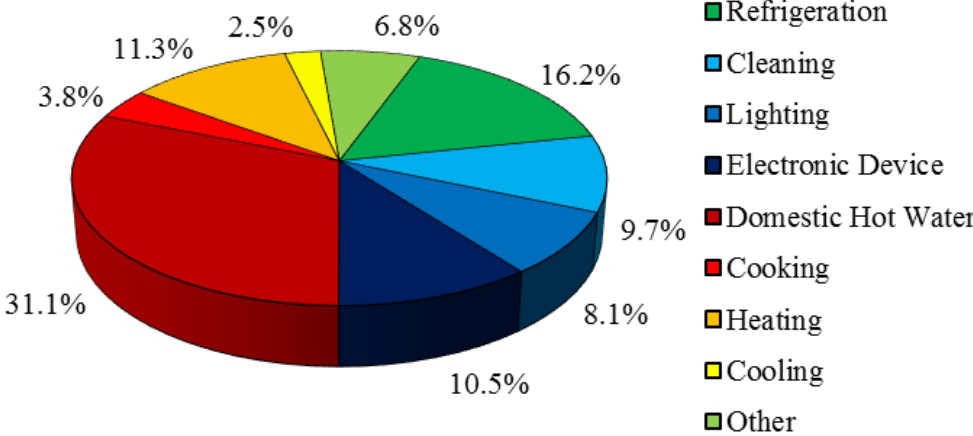
Figure 4. Share of electricity consumption in Pantelleria in the residential sector by main loads, in 2011, figure elaborated by the authors from data provided by SMEDE [87,88].